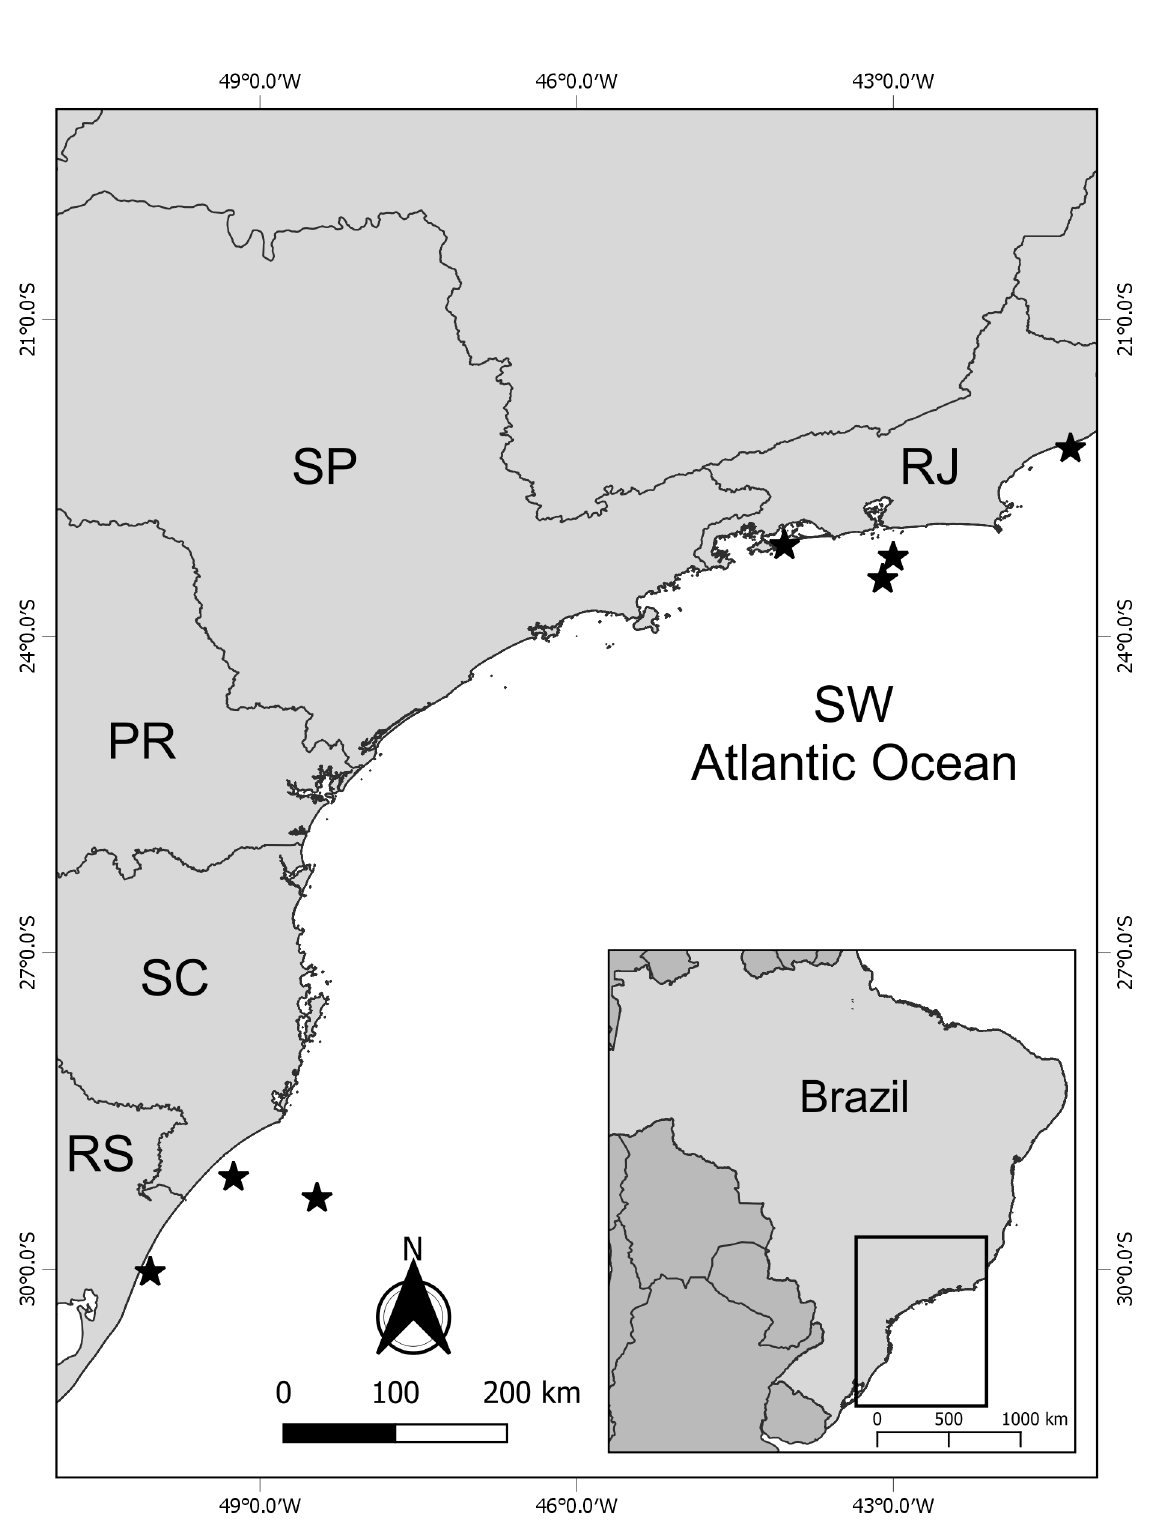
Fig. 7. Distribution of Heterophoxus shoemakeri sp.